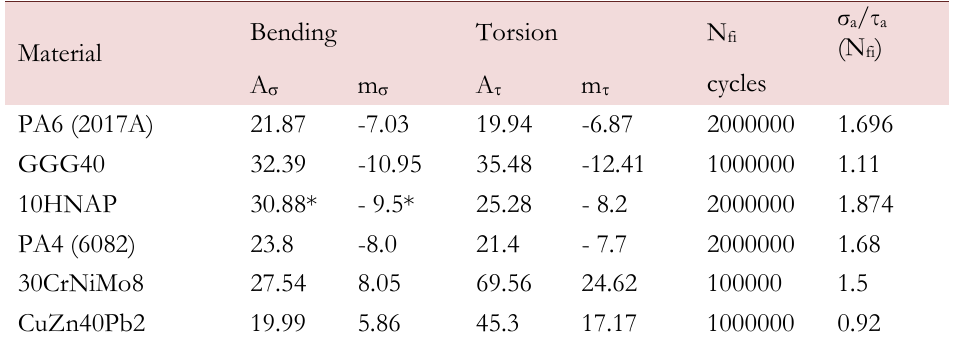
Table 1: Coefficients of regression equation for analysed materials. 0 ,45     . For each of the 46 angles calculated parameters B and K in accordance with the formulas (13) and (14). Fig. 2 presents B and K constants depending on the angle β for the PA4 aluminum alloy.